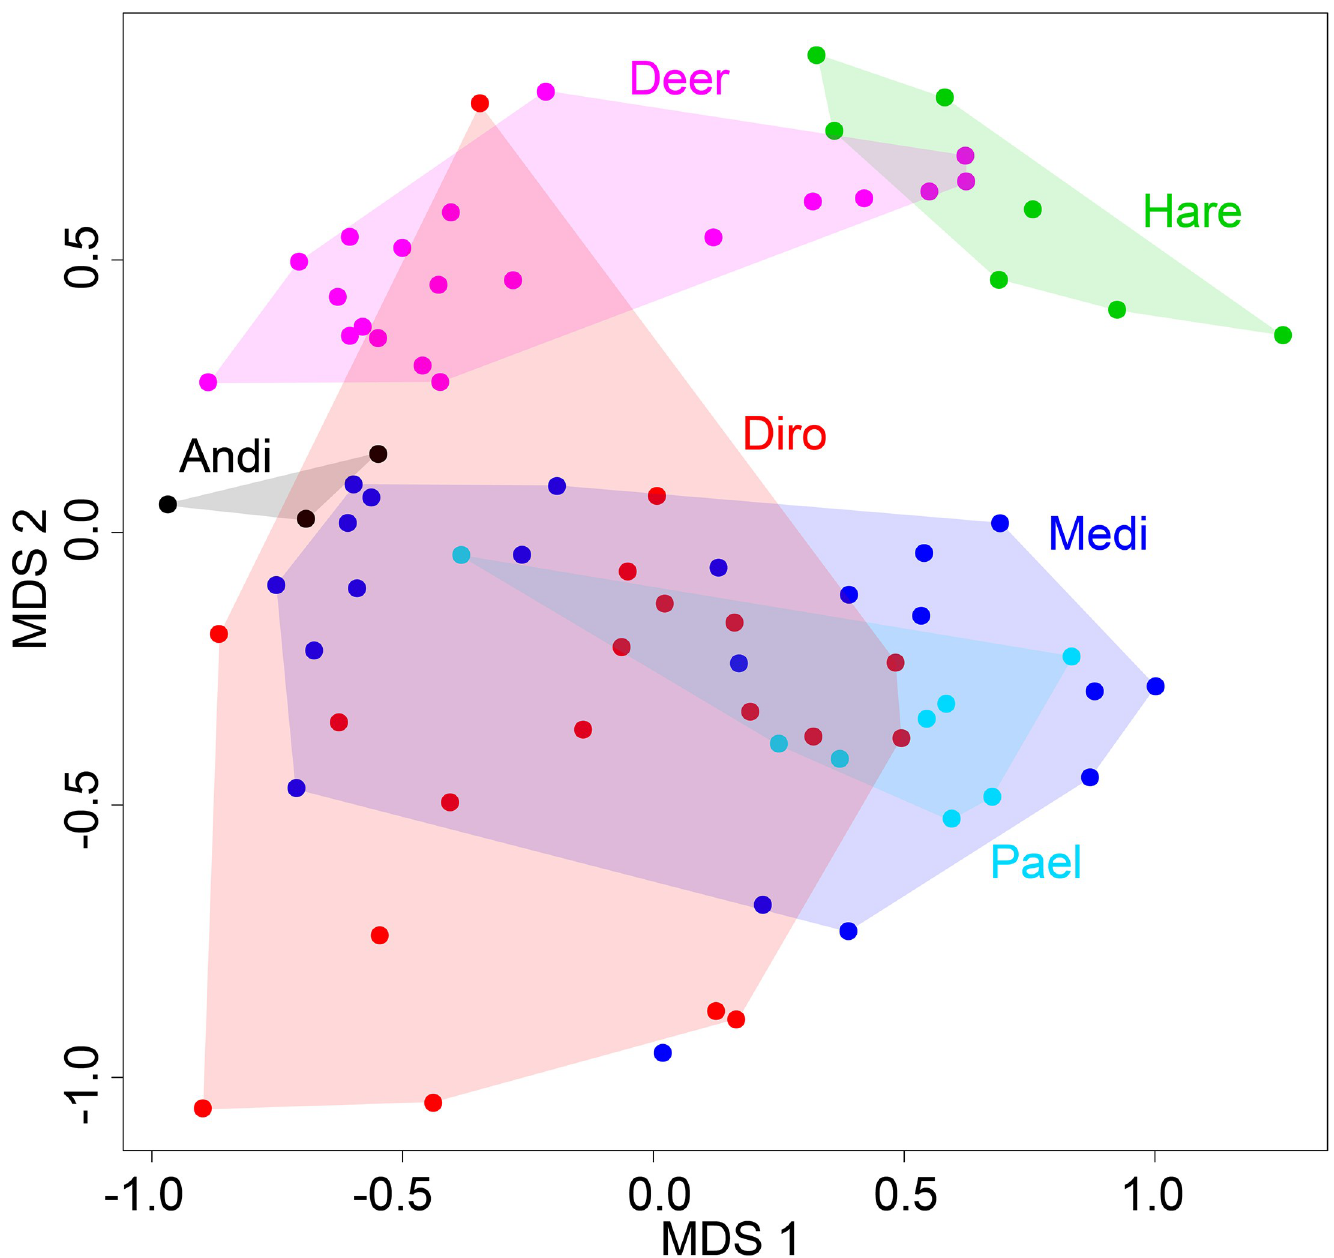
Fig 7. MDS based on pollen and spore assemblages. Moa coprolites (Pael, Pachyornis elephantopus ; Medi, Megalapteryx didinus ; Diro, Dinornis robustus ; Andi, Anomalopteryx didiformis ) and deer and hare pellets from Daley’s Flat rock avalanche deposit.